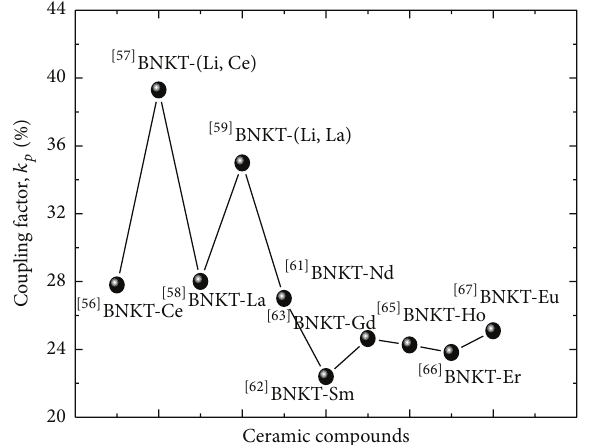
Figure 1: The effect of electric coupling factor in case of various dopants in